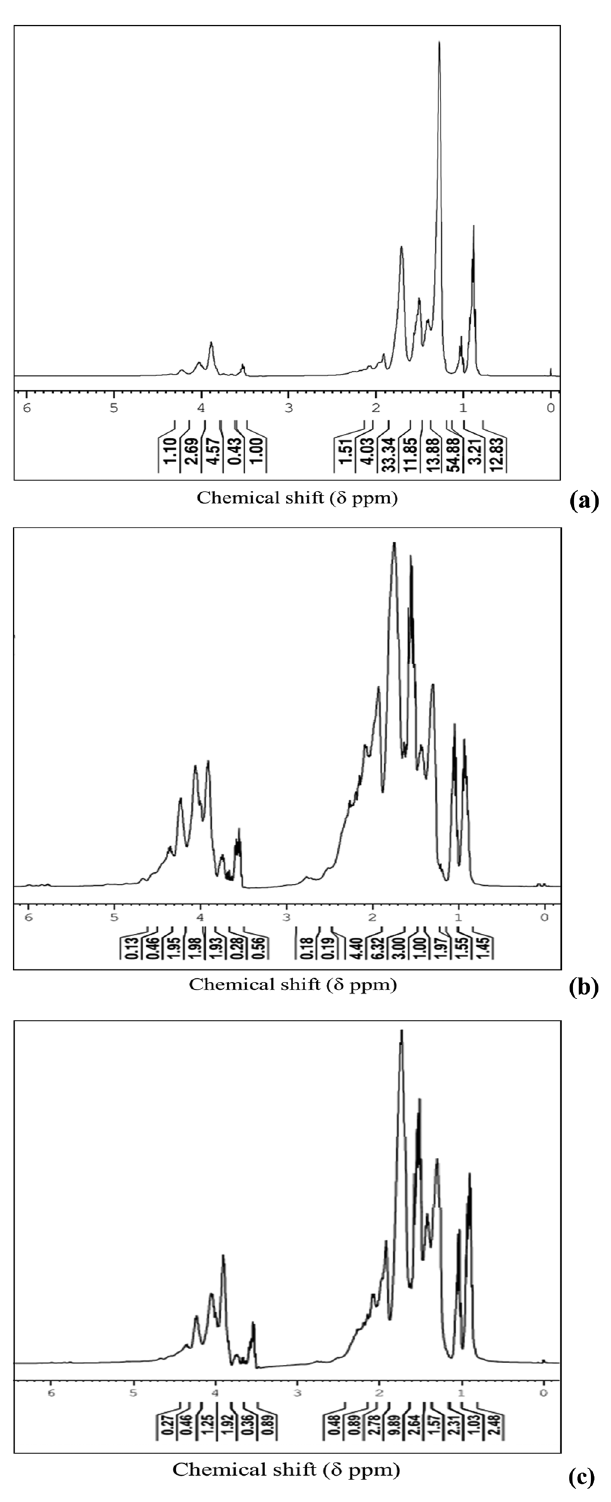
Figure 8: 1 H NMR spectrum of co - chlorinated LDPE post separation after ( a ) 9 h and ( b ) 18 h ( in both cases: 130°C, chlorine fl ow rate 350 mL · min − 1 , 10% LDPE concentration, and 400 rpm ) ; ( c ) 1 H NMR spectrum of chlorinated LDPE using CCl 4 as solvent ( post separation ) . Figure 9: DSC thermograms to con